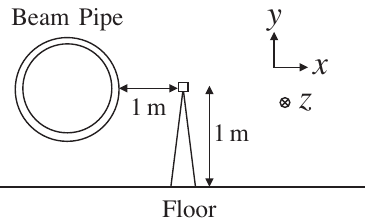
FIG. 2. Placement of the sensors relative to the beam